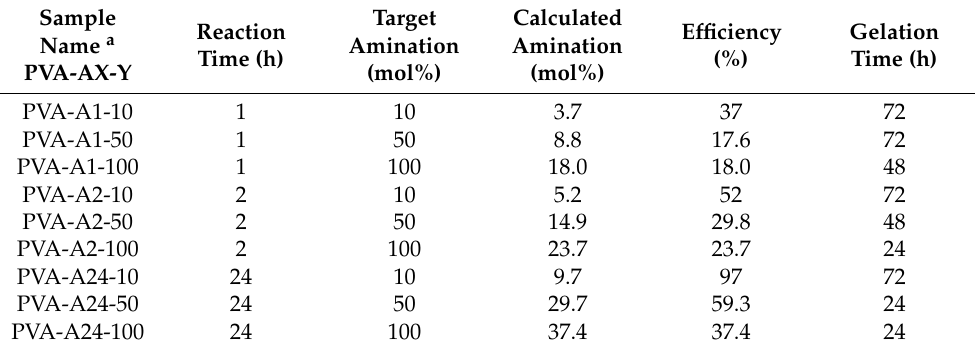
Figure 3. Representative 1 H NMR spectra of modified polymers used in this study. ( A – D ) 1 H NMR spectrum of different PVA amination for 24 h reaction time point (sample nomenclature PVA- AX-Y, where X corresponds to the reaction time (h) and Y to the maximum theoretical amination percentage). ( A ) Pure PVA, ( B ) PVA-A24-10, ( C ) PVA-A24-50, and ( D ) PVA-A24-100. Successful backbone modification was verified by the peak at 2.9 ppm corresponding to amine linker. ( E ) 1 H NMR spectrum of norbornene-modified PVA. Successful backbone modification was verified by vinyl peak at 6.25 ppm. Table 1. Poly(vinyl alcohol) (PVA) amination in different concentrations and different time points. The results of the gelation time of the different PVA modified with amine groups (PVA-A) polymers using genipin (0.1% wt/wt) as a